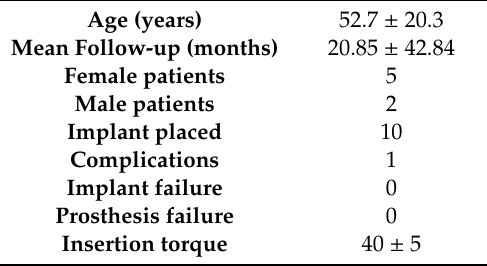
Table 1. Main patient and implant characteristics.